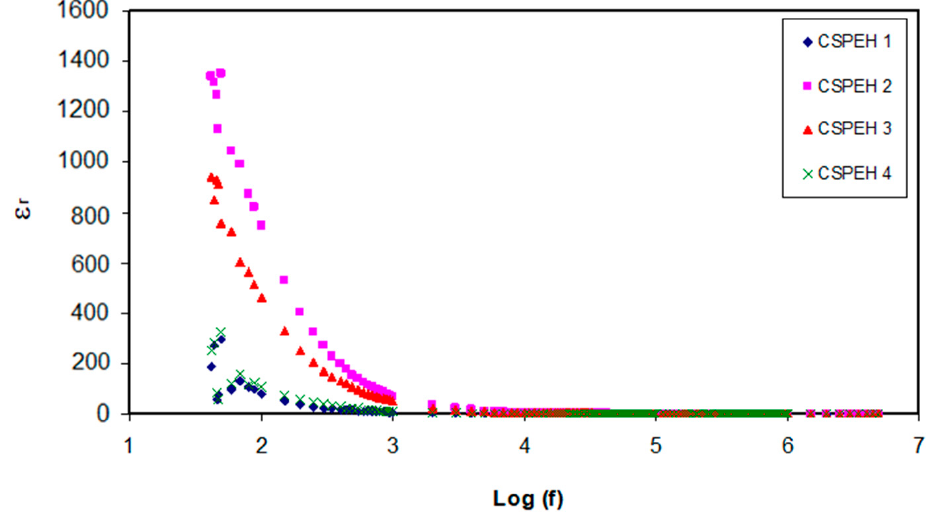
Figure 6. Dielectric constant in opposition to frequency logarithmic scale for the electrolytes.